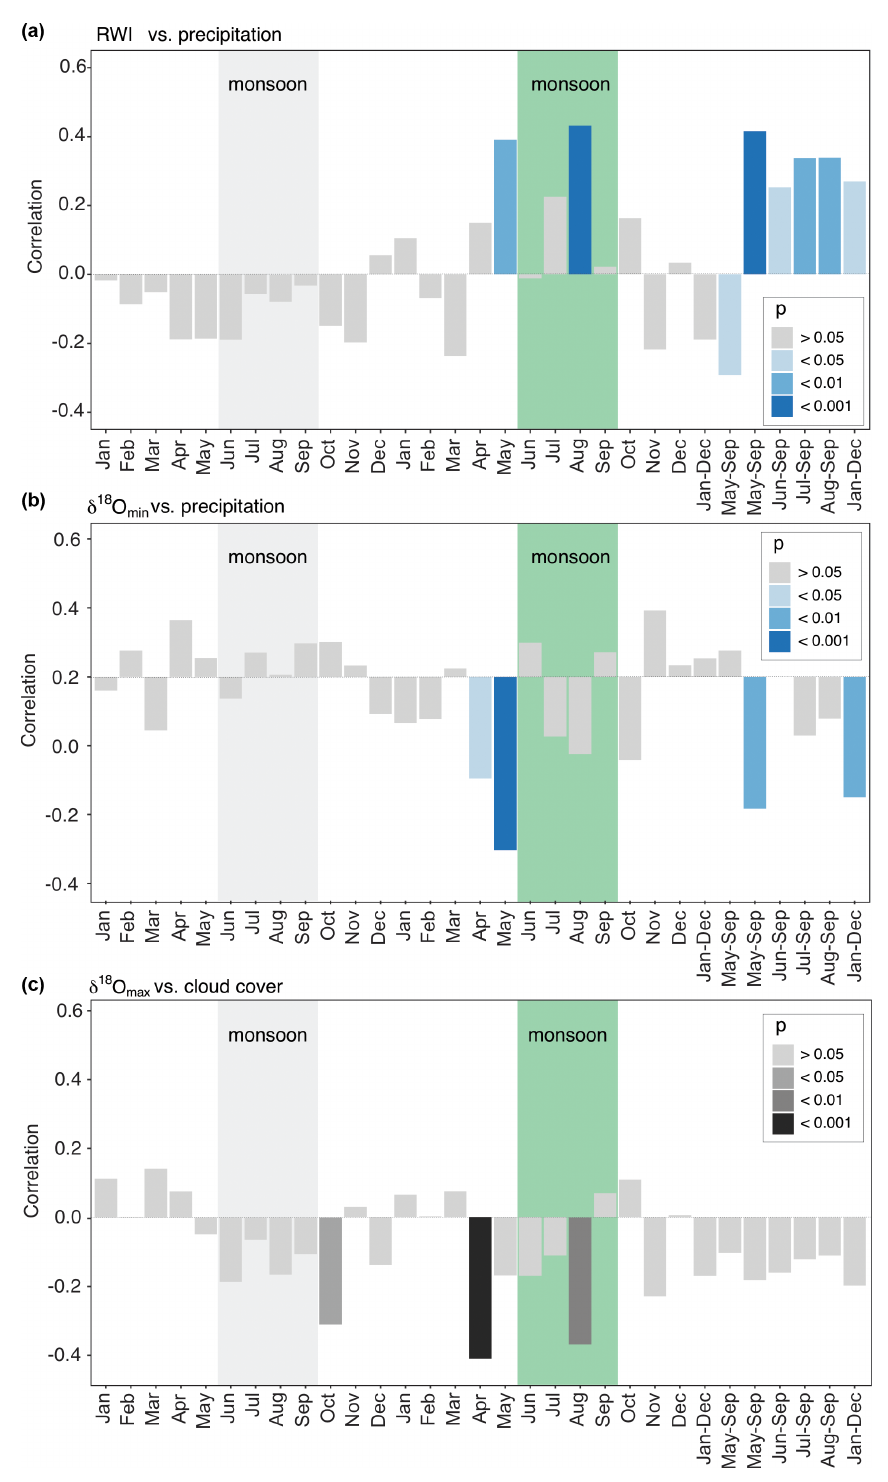
Figure 7. Diagrams for the strongest correlations of baobab tree-ring parameters with monthly and seasonally resolved climate parameters. Months of the previous year are marked by lowercase abbreviations and months of the current year by uppercase abbreviations. The green box marks the average monsoon period. (a) Ring-width indices versus precipitation amount. (b) δ 18 O min versus precipitation. (c) δ 18 O max versus cloud cover. Apart from the actual monsoon season (June–September) also the pre-monsoon (April–May) has a significant influence on wood increment growth and δ 18 O isotope